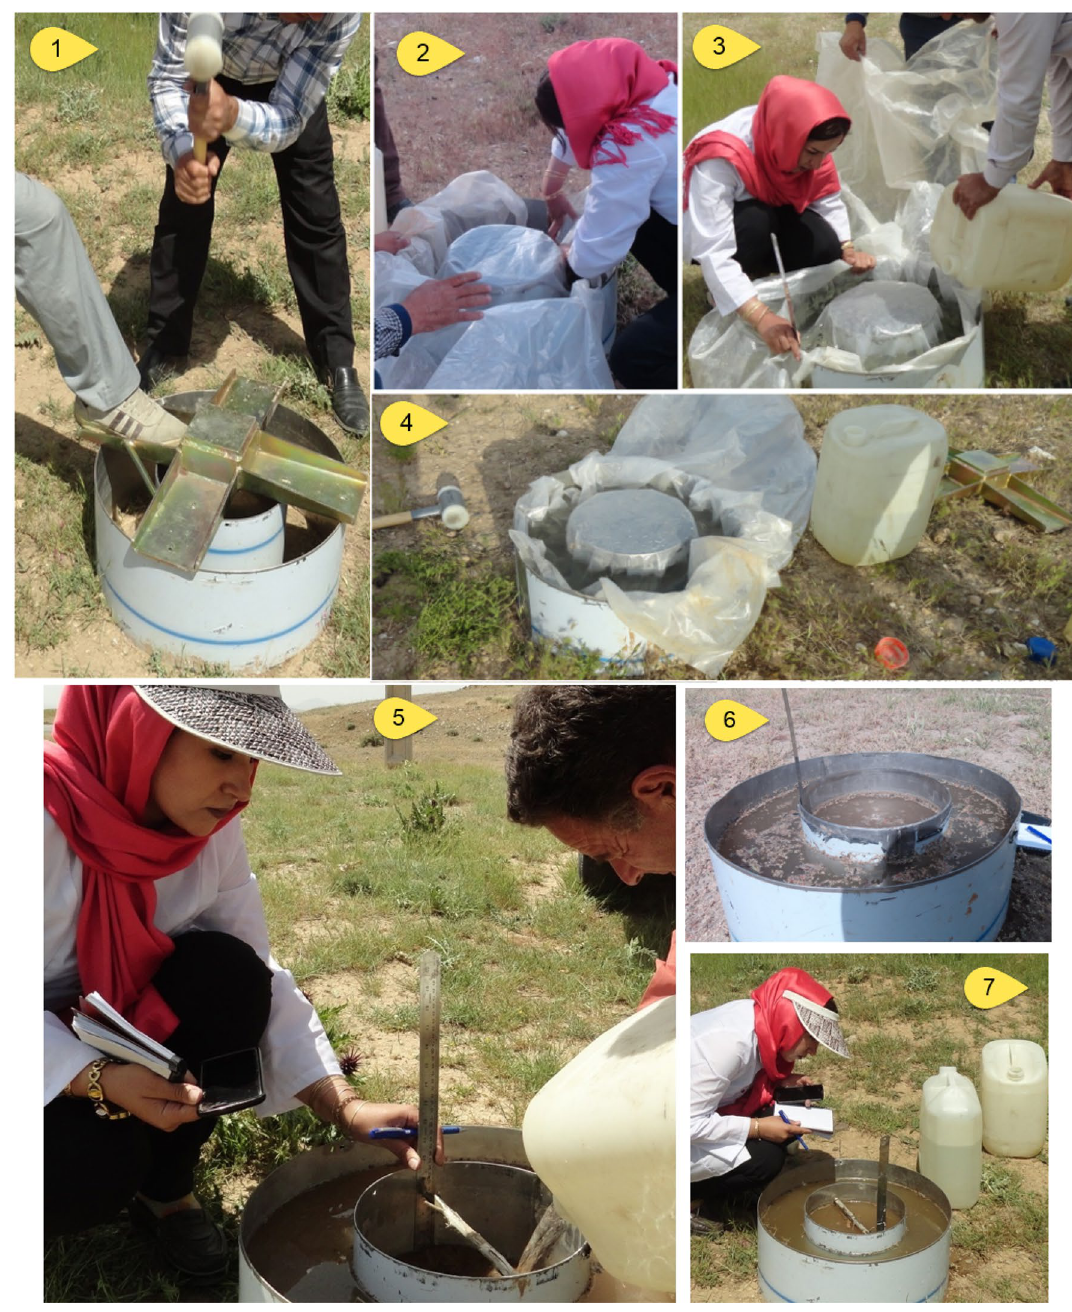
Figure 3. Double-ring infiltrometer method in the study